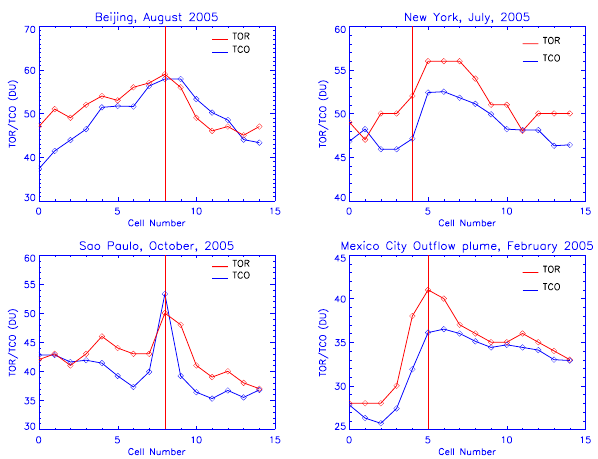
Fig. 2. Comparison of the upstream and downstream TOR/TCO values for the 4 urban plume examples shown in Fig. 1. The TOR and TCO values were sampled along the black lines shown in Fig. 1. The vertical red line indicates the position of the grid cell closest to the city. Note the vertical scales are different in each